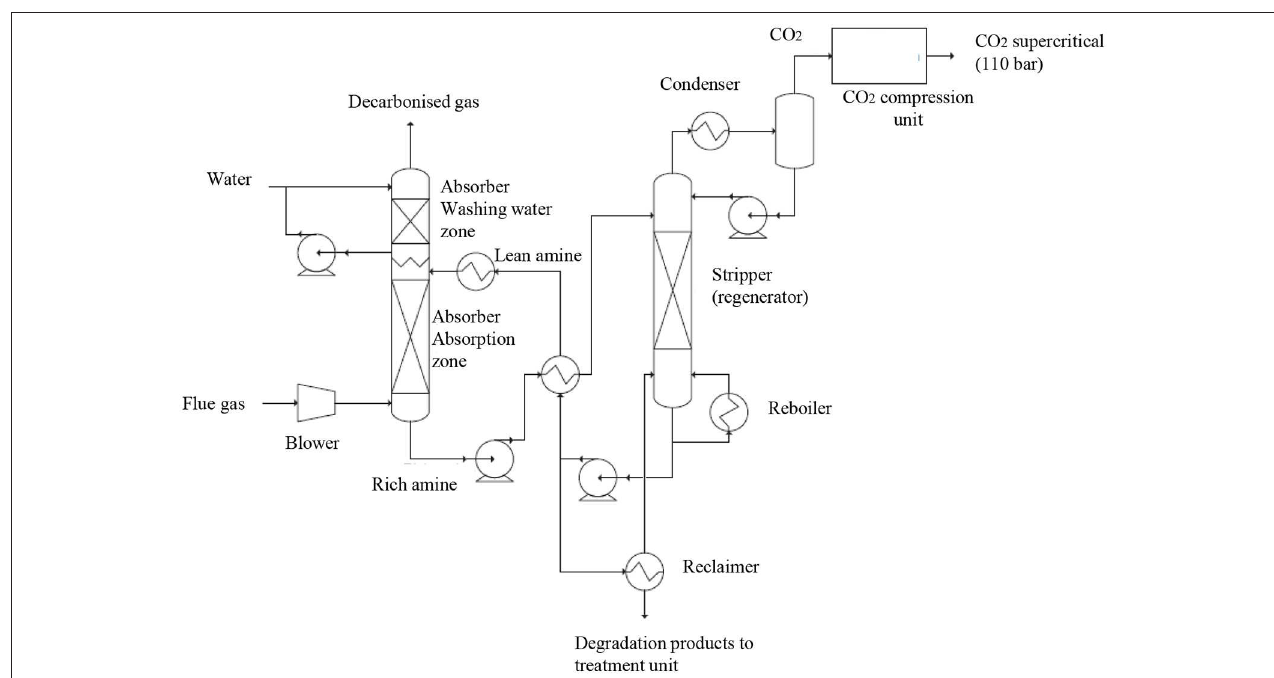
FIGURE 5 | Simplified process flow diagram of the HiCapt + process, reprinted from Digne et al. (2014) with permission from IFP Energies nouvelles (Oil & Gas Science and Technology). a CO 2 recycling system was retrofitted to a pilot-scale FCC